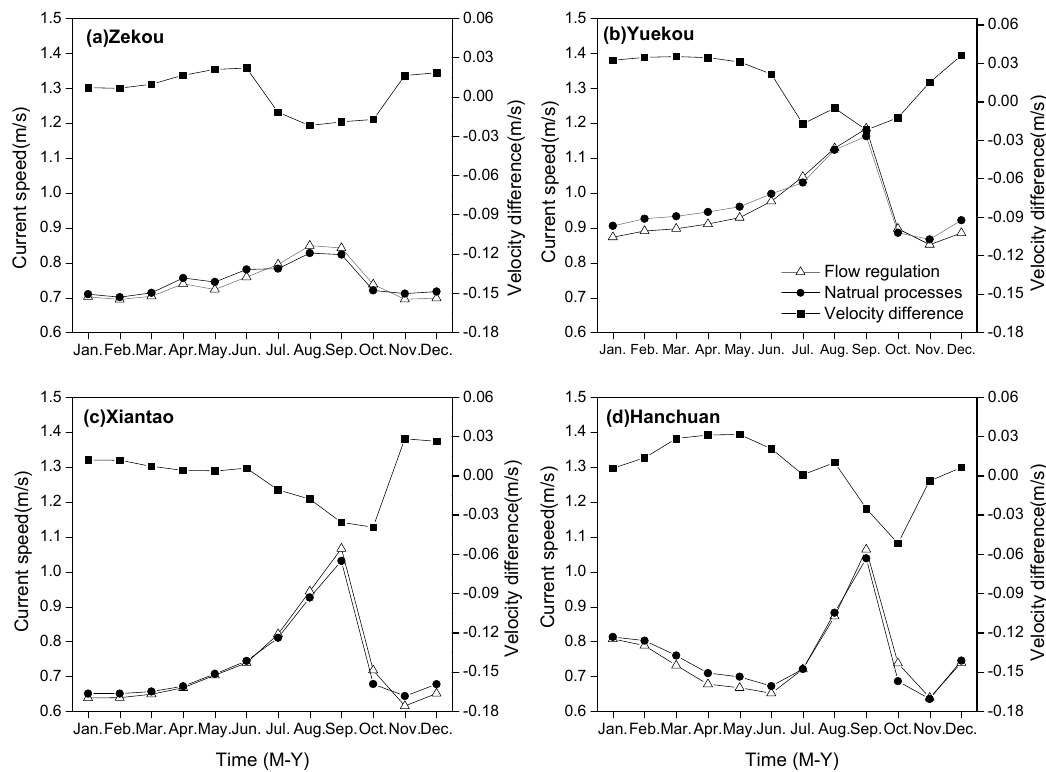
Figure 9. Comparison of the monthly average current speed between the natural processes and the processes under the TGR operation at the different gauging stations along the lower Han River. The positive velocity differences indicate the velocities at the gauging stations are smaller than the ones of the natural processes and vice versa.